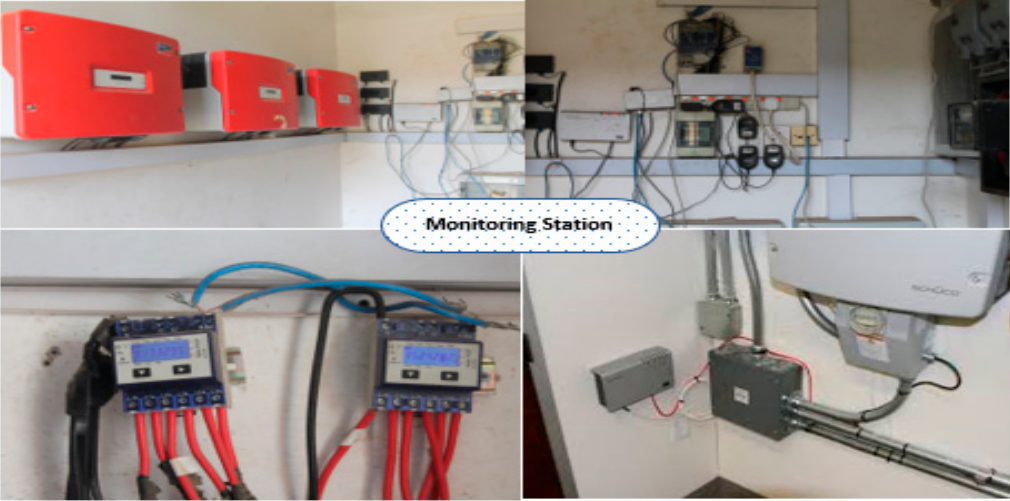
Figure 2. Monitoring station for outdoor test set-up at College of Engineering KNUST, Kumasi, Ghana.